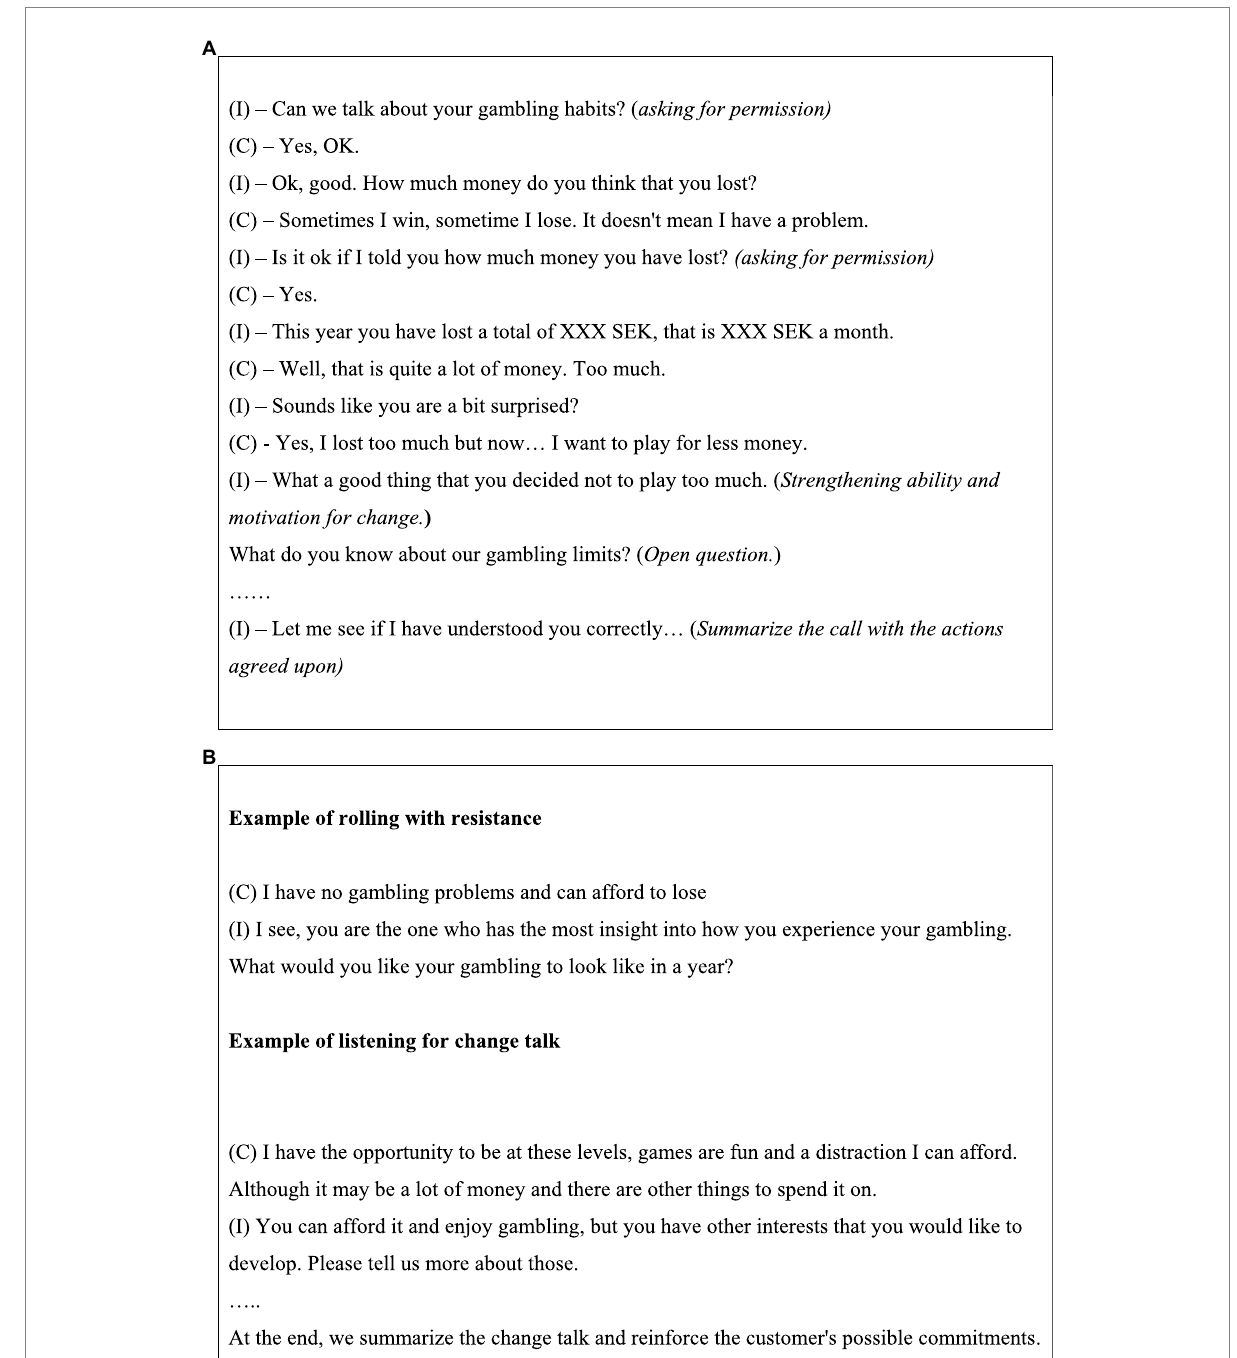
FIGURE 1 (A) Example of motivational intervention call, in a shortened and simplified dialogue format between interviewer (I) and client (C). (B) Examples of “rolling with resistance” and “listening to change talk” as within the motivational intervention